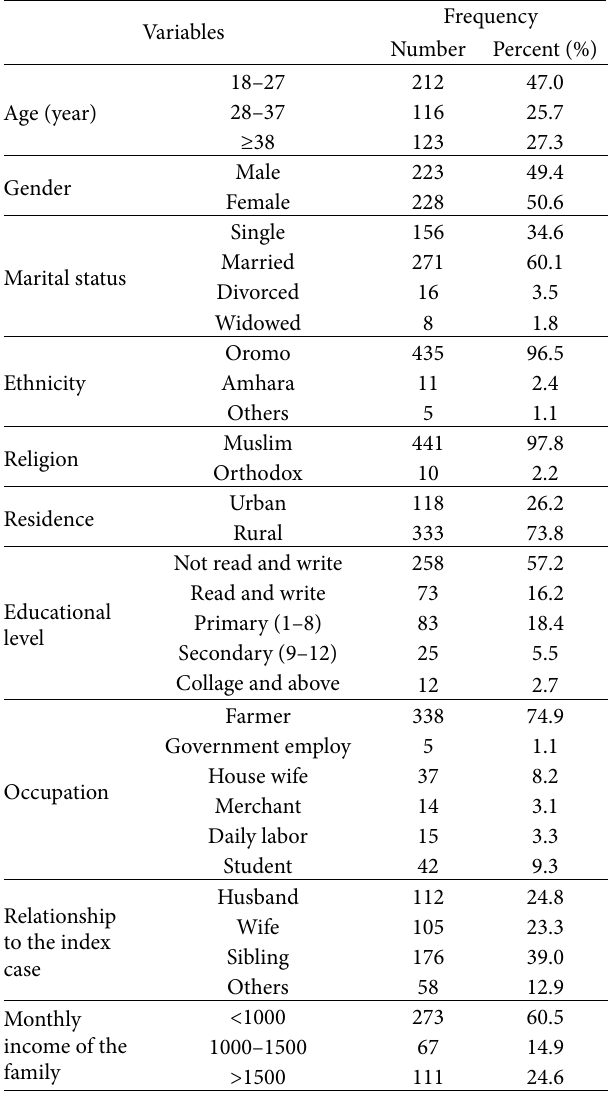
Table 1: Socio-demographic characteristics of adult household contacts of smear positive PTB patients in Haramaya district, Eastern Ethiopia, 2019 ( 푛 = 451